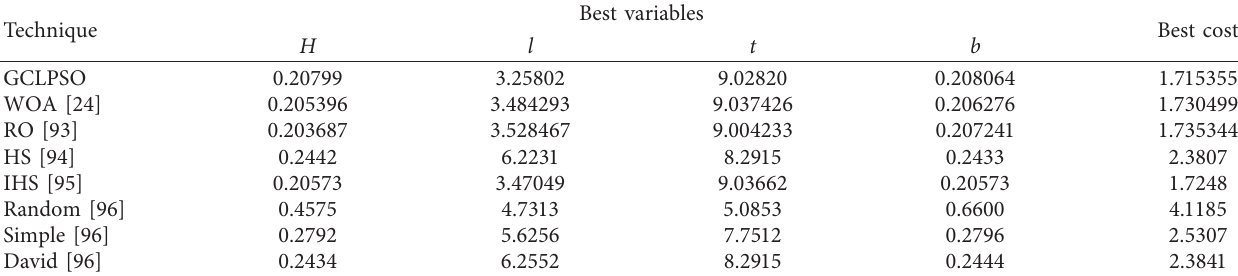
Table 10: Comparison of the GCLPSO with other methods for the welding beam design problem.